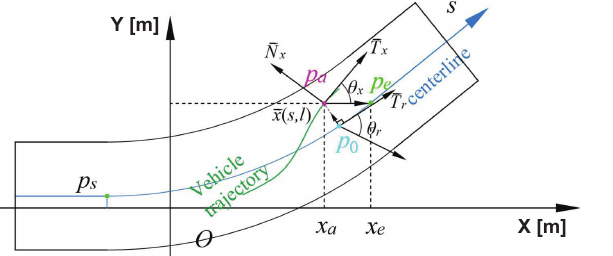
Figure 2. Diagram of coordinate systems conversion. p s is the starting point, p e is the ending point. p a is the point on the trajectory of the vehicle to be converted. p 0 is the nearest point that works as the reference point to convert p a . (cid:126) T x is the reference curve tangent vector in the Frenet coordinate system, and (cid:126) N x is the normal vector in the Frenet coordinate system. (cid:126) x ( s , l ) is the Frenet coordinate of (cid:126) x